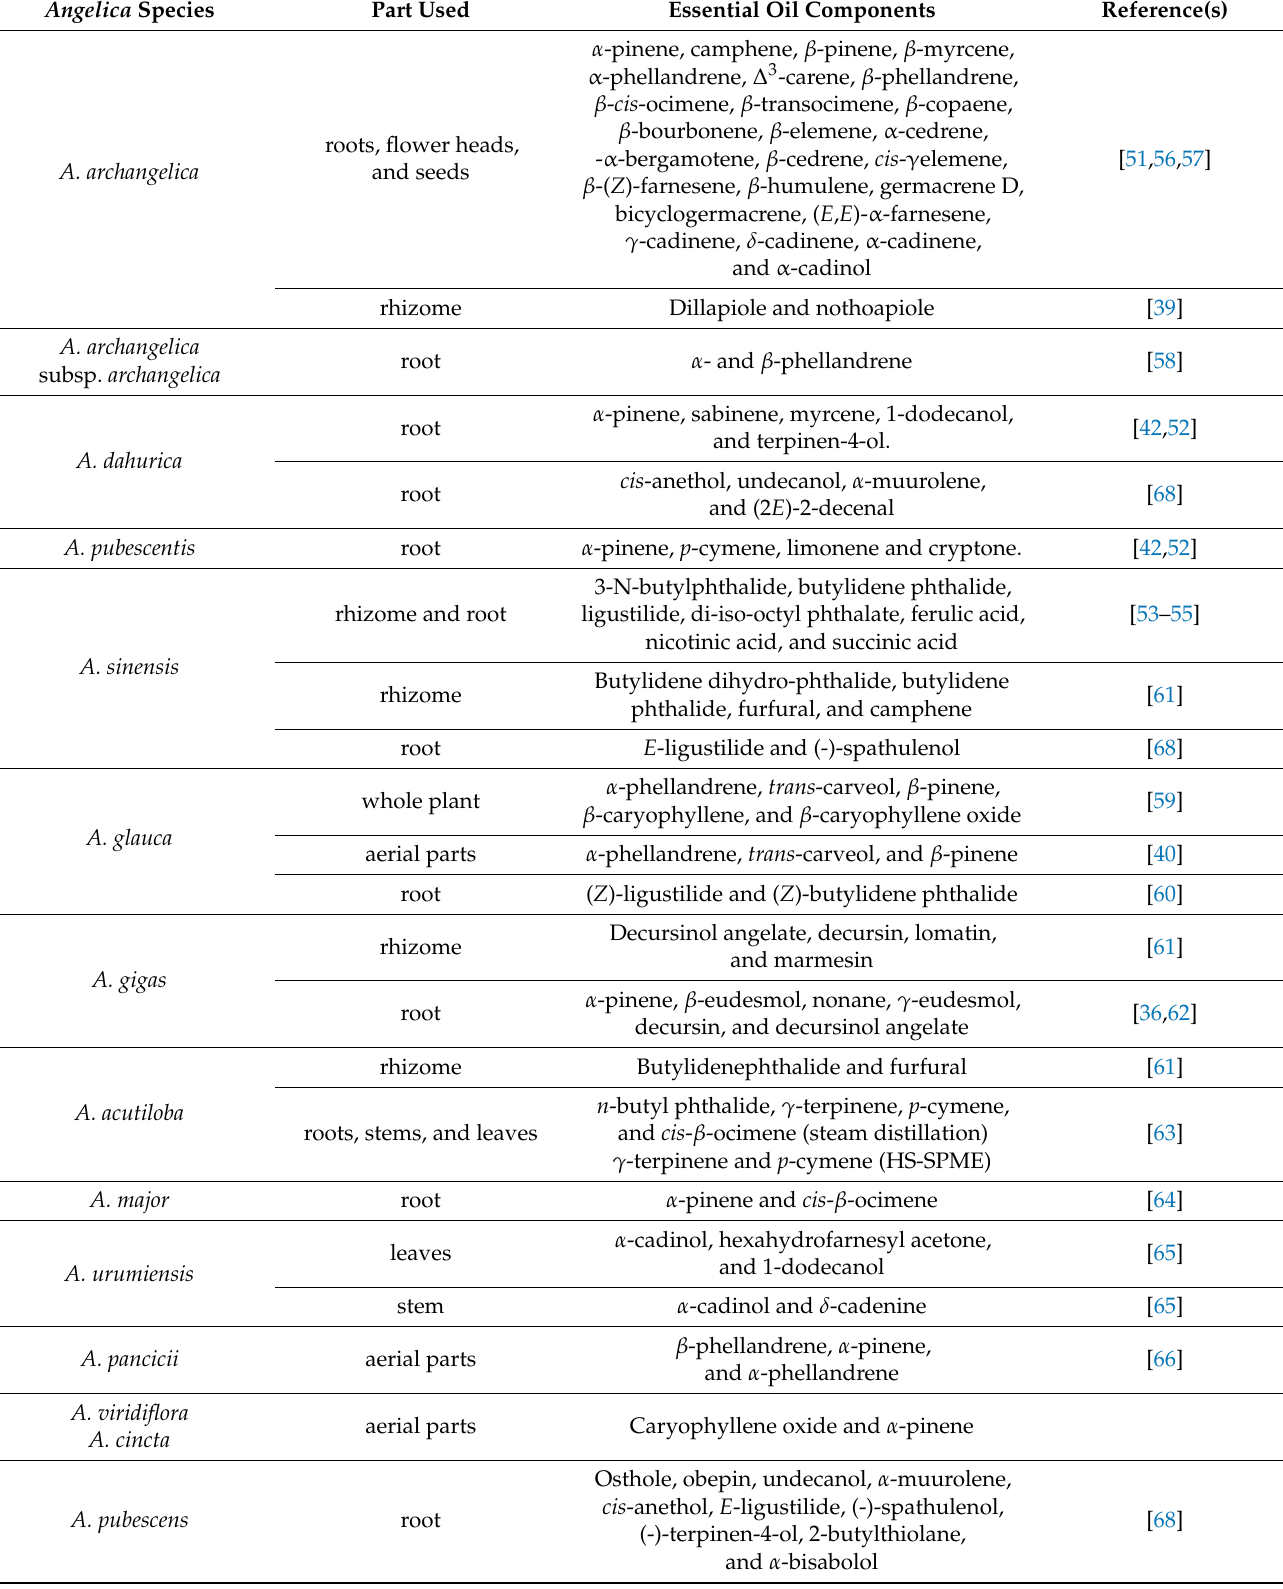
Table 2. Essential oil composition of selected species from genus Angelica